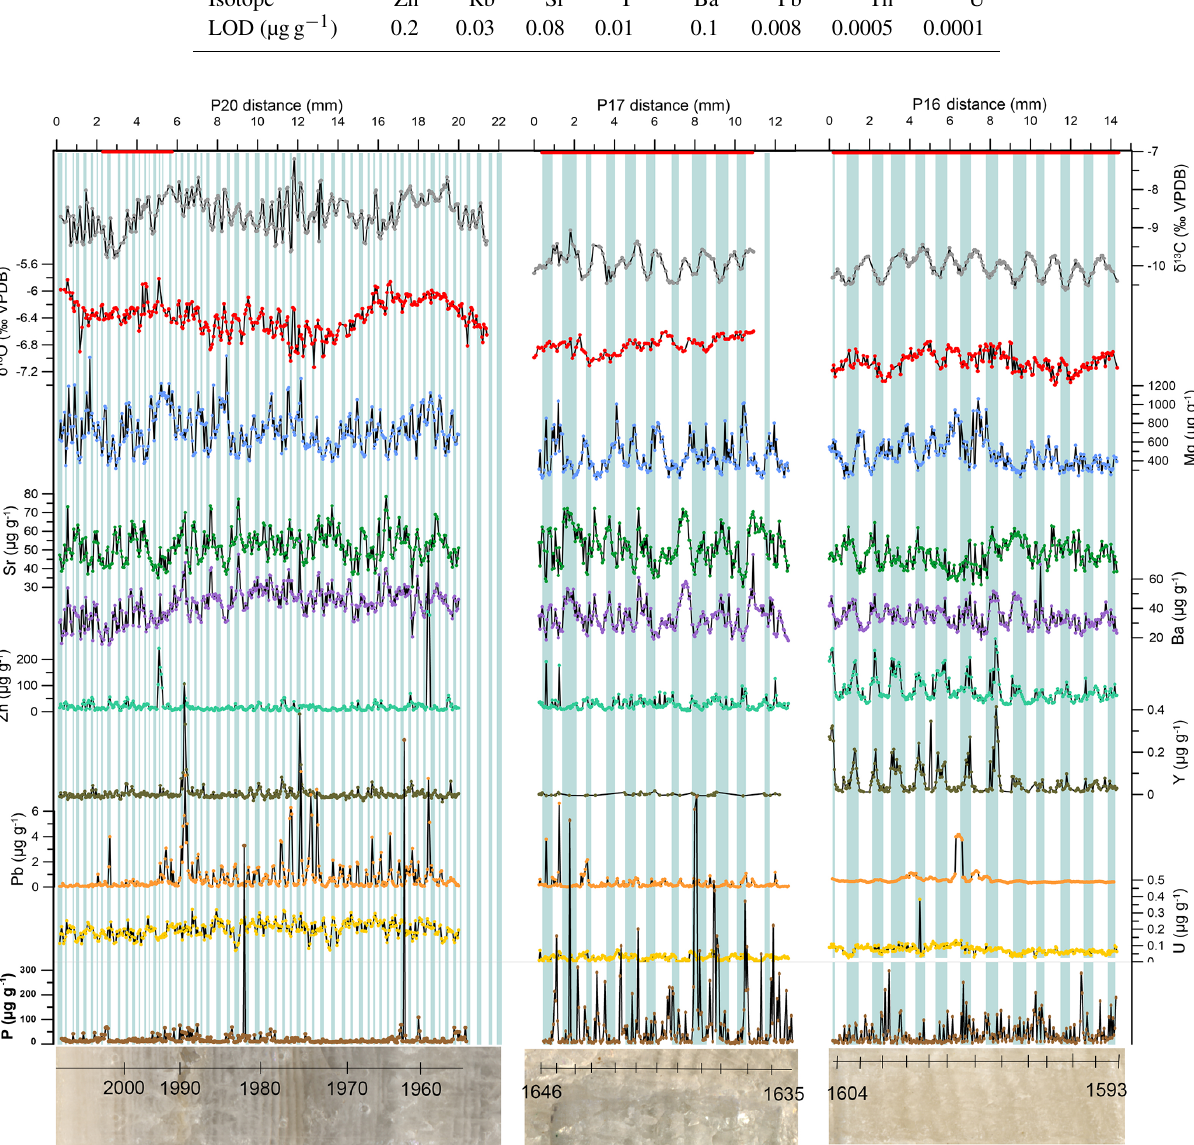
Figure 4. Stable-isotope ratios and trace-element variations plotted against distance for P20, P17 and P16. Blue bars mark the DCL laminae. The left side represents the youngest layers. All stable-isotope ratios are expressed as ‰ VPDB, and trace-element concentrations are reported in parts per million (ppm). Red bars indicate years used for annual stack (Figs. 7 and